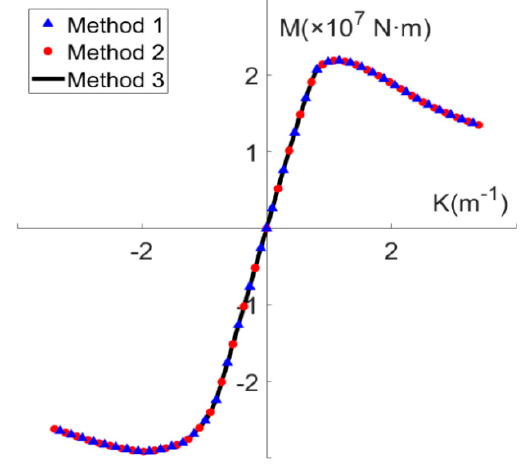
Figure 8. Bending moment in CASE 1.